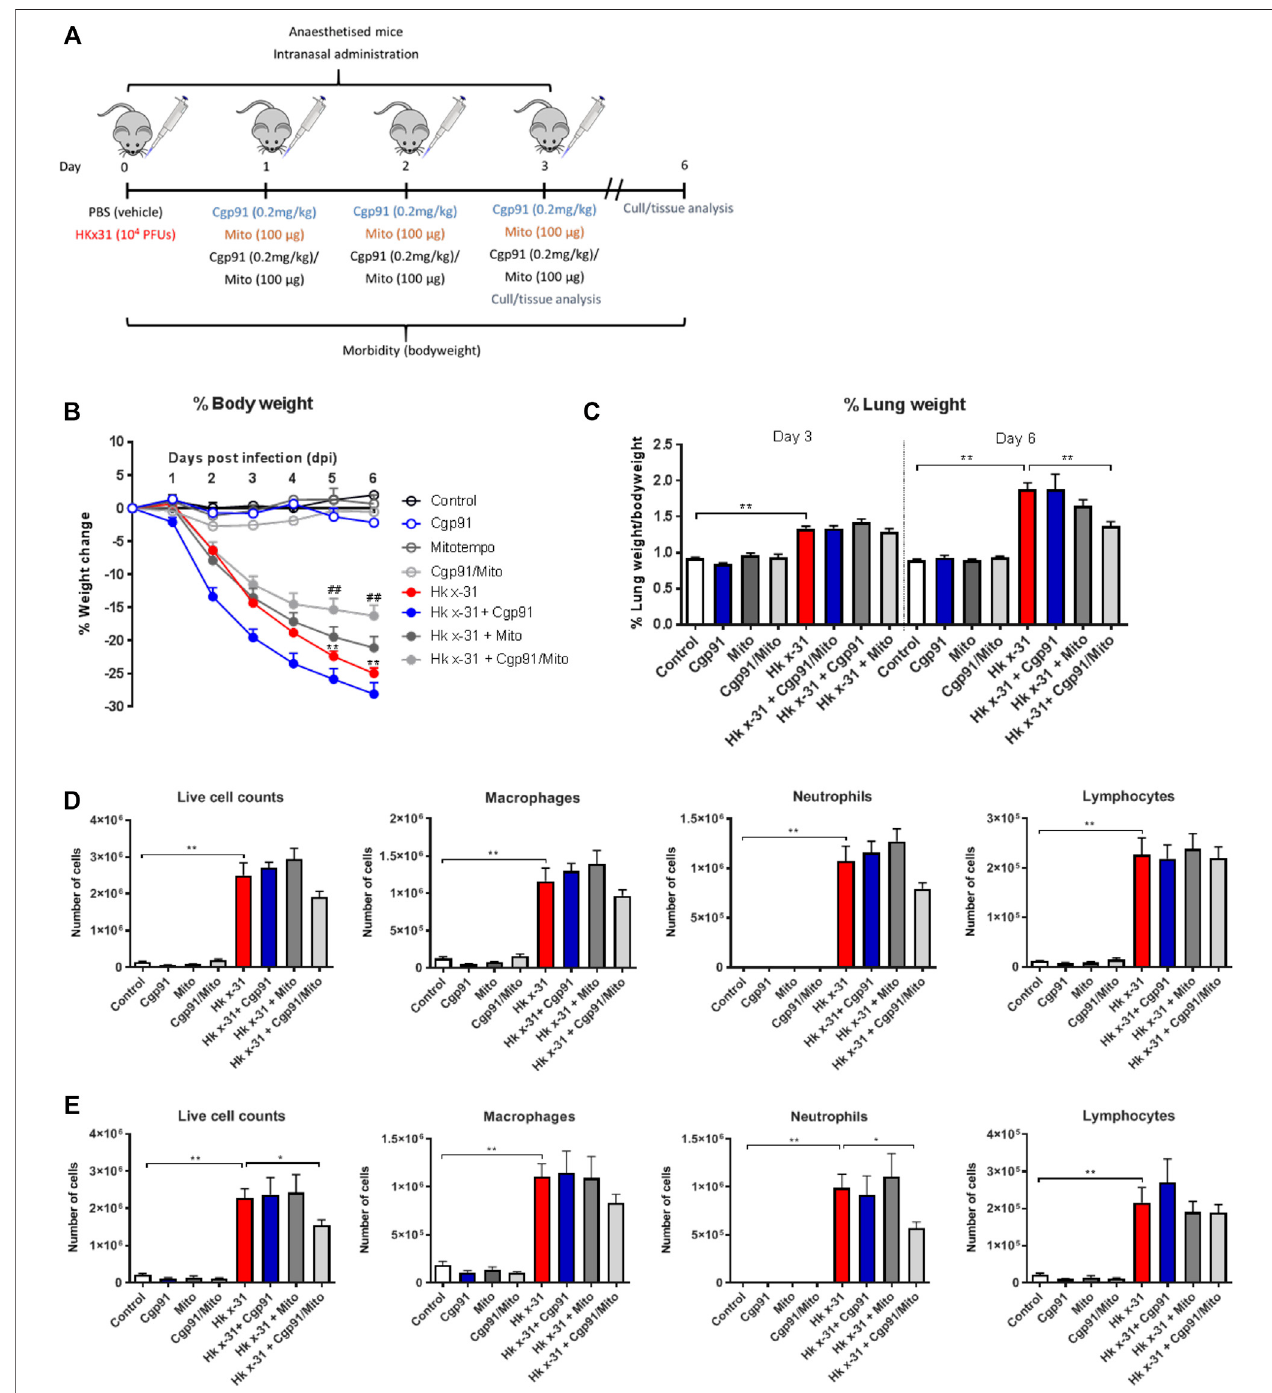
FIGURE1| CombinationtherapyofCgp91ds-TATandmitoTEMPOreducesIAV-inducedbodyweightloss,airwayin fl ammationandpulmonaryedema. (A) C57Bl/ 6J mice were treated once daily via intranasal administration of Cgp91ds-TAT (0.2 mg/kg) and mitoTEMPO (100 µg) in combination or individually over a 2 days period 1 daypost-infectionwithHKx31(10 4 PFUs)orPBS. (B) Dailybodyweightmeasurementsweretakenovertheexperimentalperiod. (C) Pulmonaryedemawasassessed bymeasuring thewetlungweight tobodyweightratioat day3piand day6pi.Airwayin fl ammationwasassessed via counting thetotalnumberoflivecellsisolated from the bronchoalveolar lavage fl uid that were differentiated into macrophages, neutrophils and lymphocytes at (D) day 3 pi and (E) day 6 pi. 500 cells were counted from random fi eldsby standard morphological criteria. Dataare expressed asmean ± SEM(Control, n = 8; Cgp91, n = 4;mitoTEMPO n = 4; Cgp91/Mito, n =8; Hkx31, n = 13; Hkx31 + Cgp91, n = 5; Hkx31 + Mito, n = 5; Hkx31 + Cgp91/Mito, n = 10). Statistical analysis was conducted using a two-way analysis of variance (ANOVA) followedbyHolm ’ sSidakpost-hocmultiplecomparisontestin ‘ BandC ’ andone-wayANOVAtestfollowedbyTukey ’ sposthoctestformultiplecomparisontestfor (D, E) . Statistical signi fi cance was taken where p < 0.05 (* denotes p < 0.05 and ** p < 0.01). ## indicates p < 0.01 against Hk x-31.